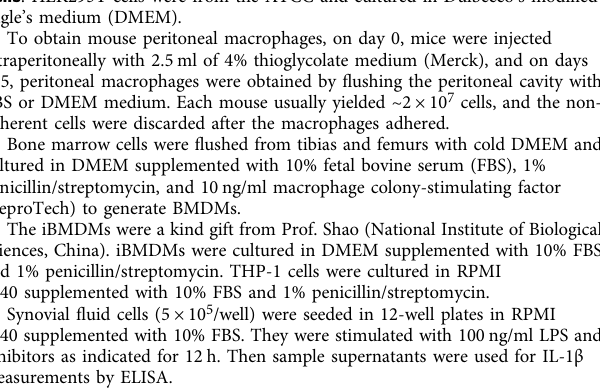
Fig. 4 Kir2.1-mediated V m supports nutrient uptake for SAM generation to induce a metabolism-responsive in fl ammatory program. a Schematic